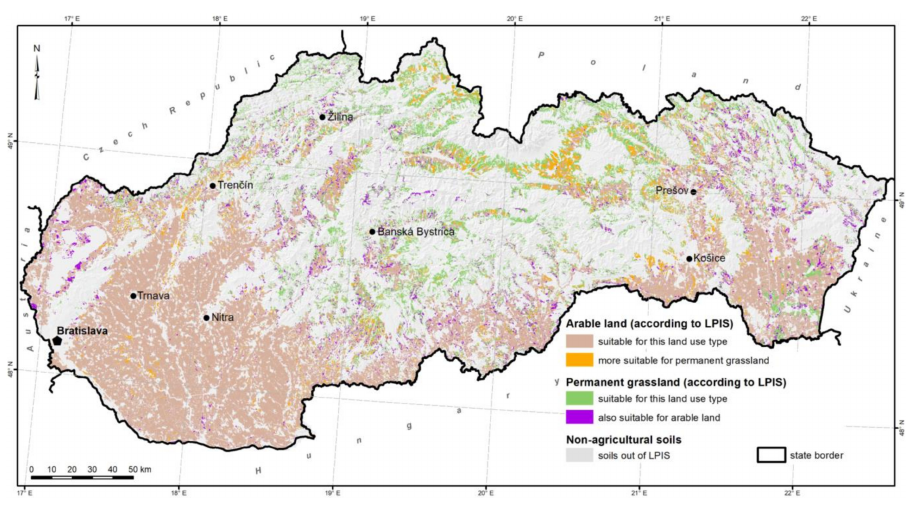
Figure 4. Soil suitability for use as arable land and permanent grassland.